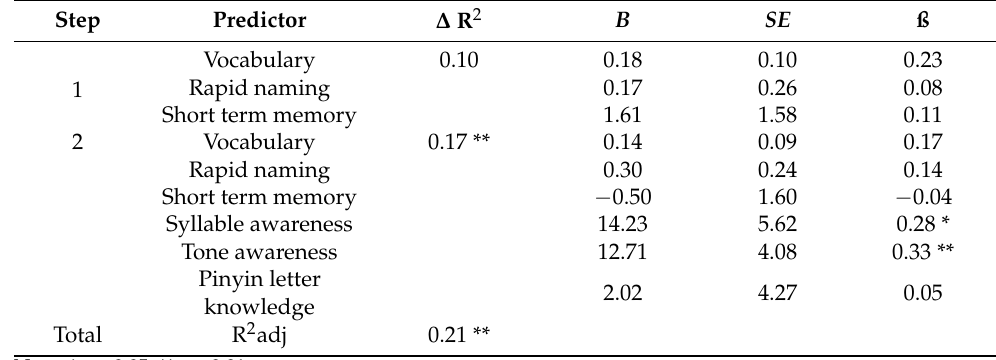
Table 3. Results of the hierarchical regression analysis in predicting Chinese character recognition after controlling for age, vocabulary, rapid naming, and short term memory (N =